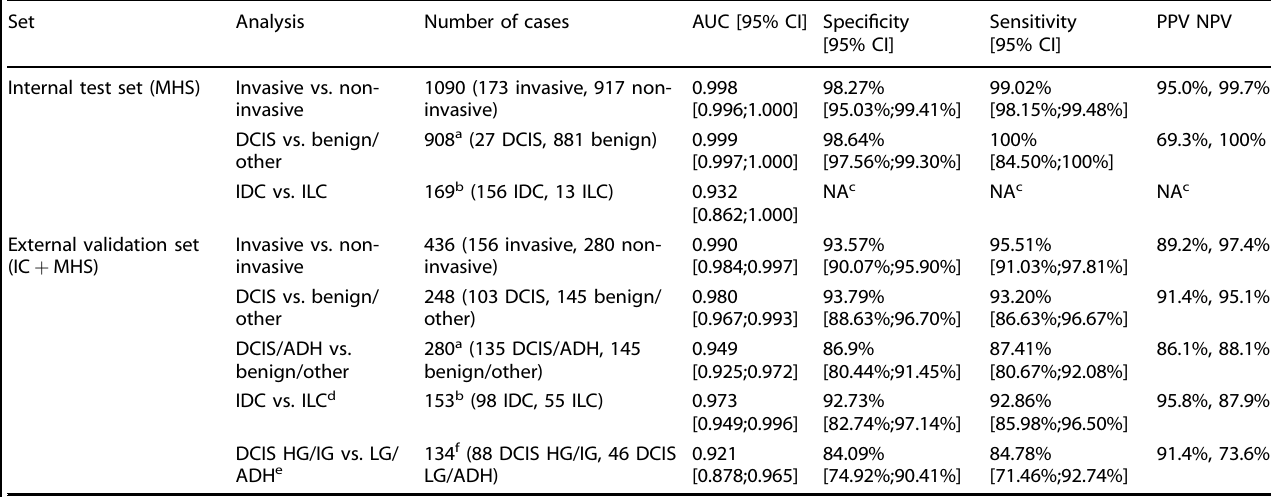
Table 2. AI algorithm performance on the internal test and external validation